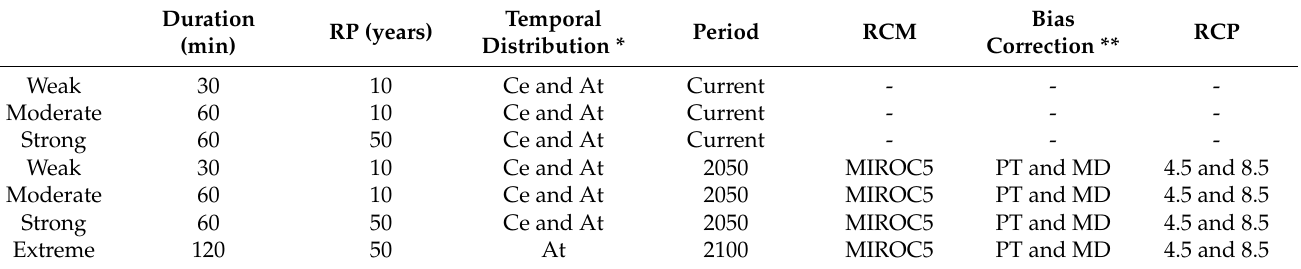
Table 4. Representative design